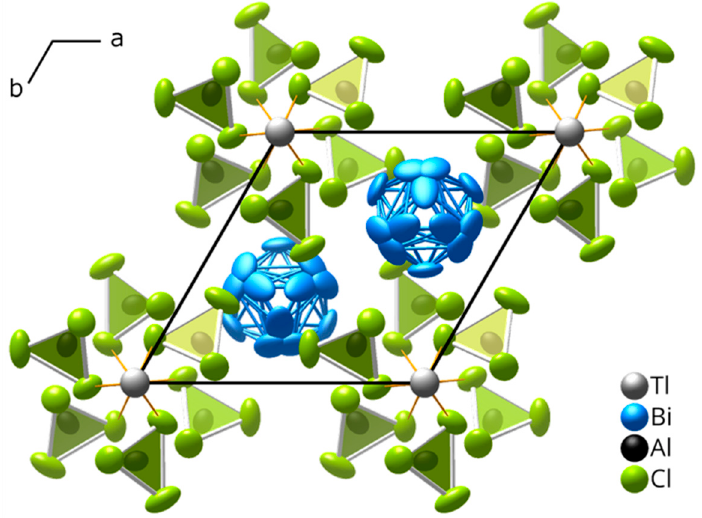
Figure 1. Crystal structure of (Bi 8 )Tl[AlCl 4 ] 3 at room temperature along [001]. Bi 82+ square antiprisms show orientational disorder. Ellipsoids comprise 90% of the probability density of the atoms.